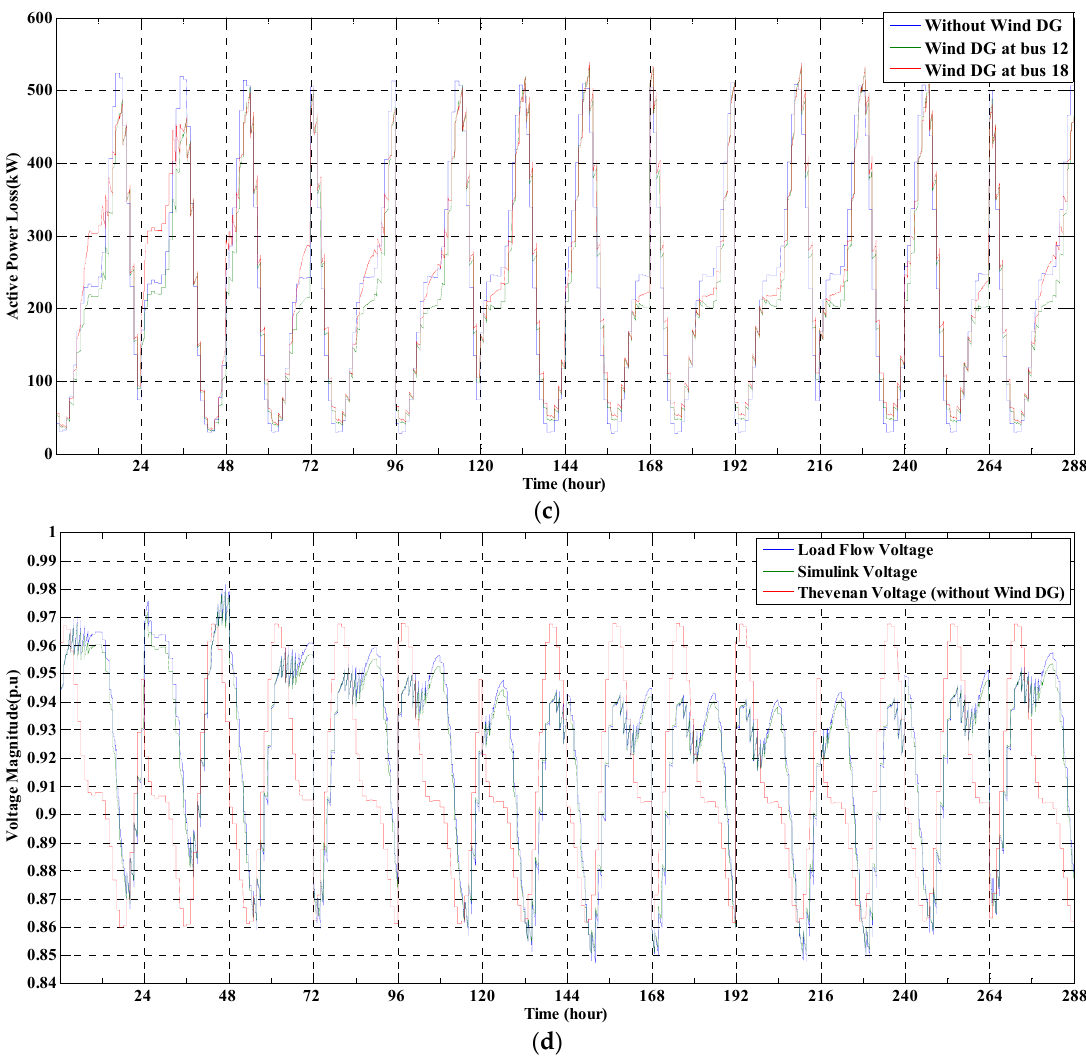
Figure 7. ( a ) Monthly average diurnal voltage patterns of bus 12, when connecting to the WDG; ( b ) Monthly average diurnal voltage patterns of bus 18, when connecting to the WDG; ( c ) Monthly average diurnal active power loss patterns, compared among three cases: Without WDG; when connecting the WDG to bus 12; and when connecting the WDG to bus 18; ( d ) Monthly average diurnal voltage patterns of bus 18, in different cases of either connecting or not connecting to the WDG.